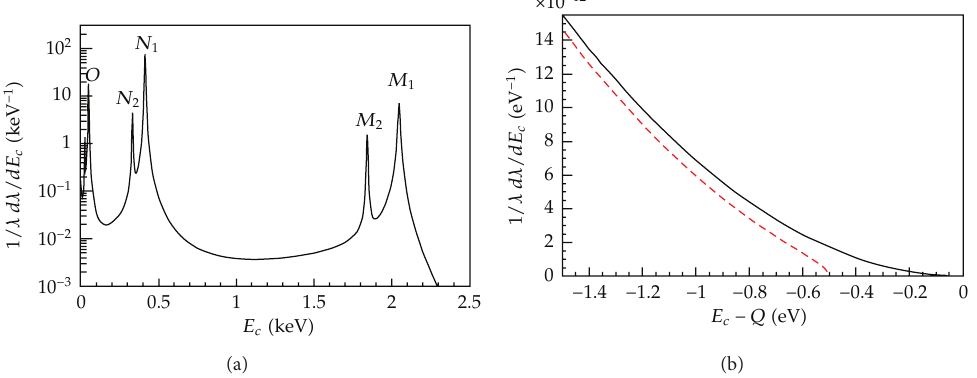
Figure 31: Deexcitation spectrum of 163 Ho for 𝑄 = 2.5 keV (a). (b) shows a zoom into the endpoint region of the spectrum with the effect of a 0.5eV neutrino mass indicated by the red dashed line (reprinted from [182], Copyright 2011, with permission from Elsevier).